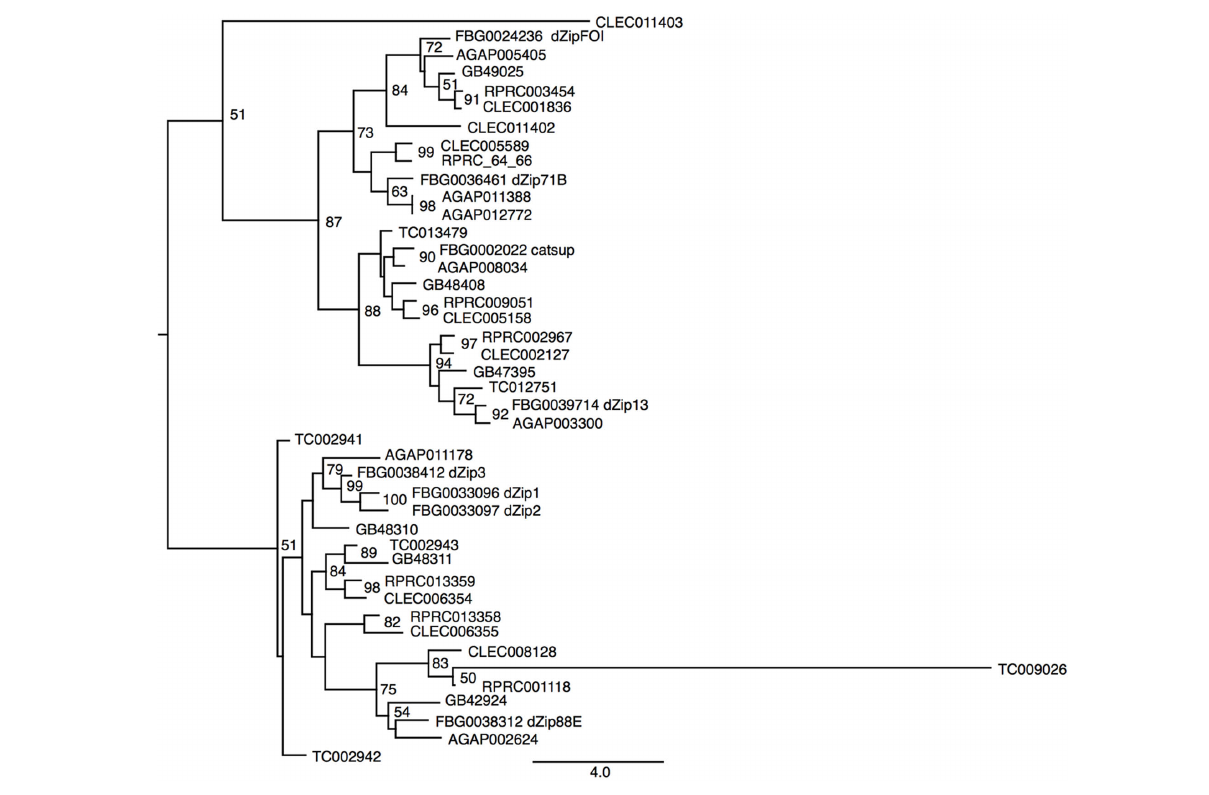
FIGURE 6 | Phylogenetic analysis of ZIP orthologs. Maximum-likelihood tree of ZIP orthologs. Numbers on the branches are bootstrap support values from 500 replicates. Only numbers 50% or higher are shown. The sequence codes used were R. prolixus (RPRC), D. melanogaster (FBg), T. castaneum (TC), C. lectularius (CLEC), A. mellifera (GB), and A. gambiae (AGAP). D. melanogaster gene names were included in the figure to allow the identification of ZIP